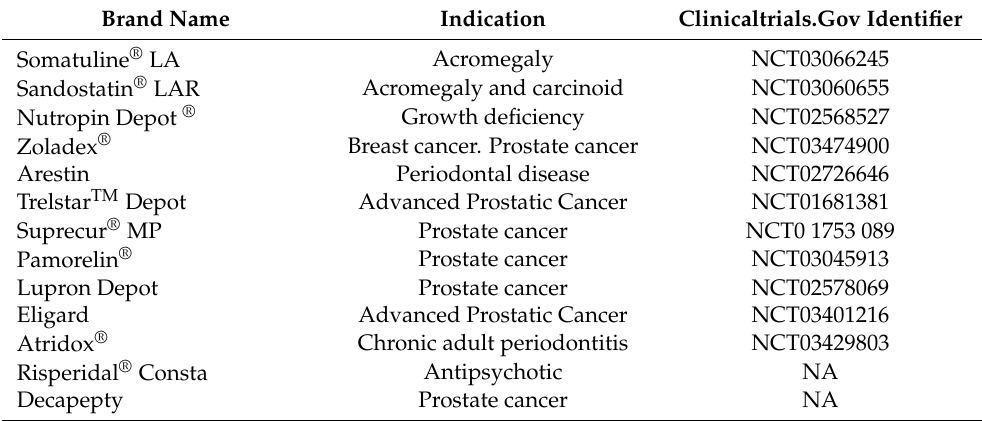
Table 3. Selected clinical trials enlisted in clinicaltrials.gov website for marketed PLGA-based therapeutics. Reproduced from